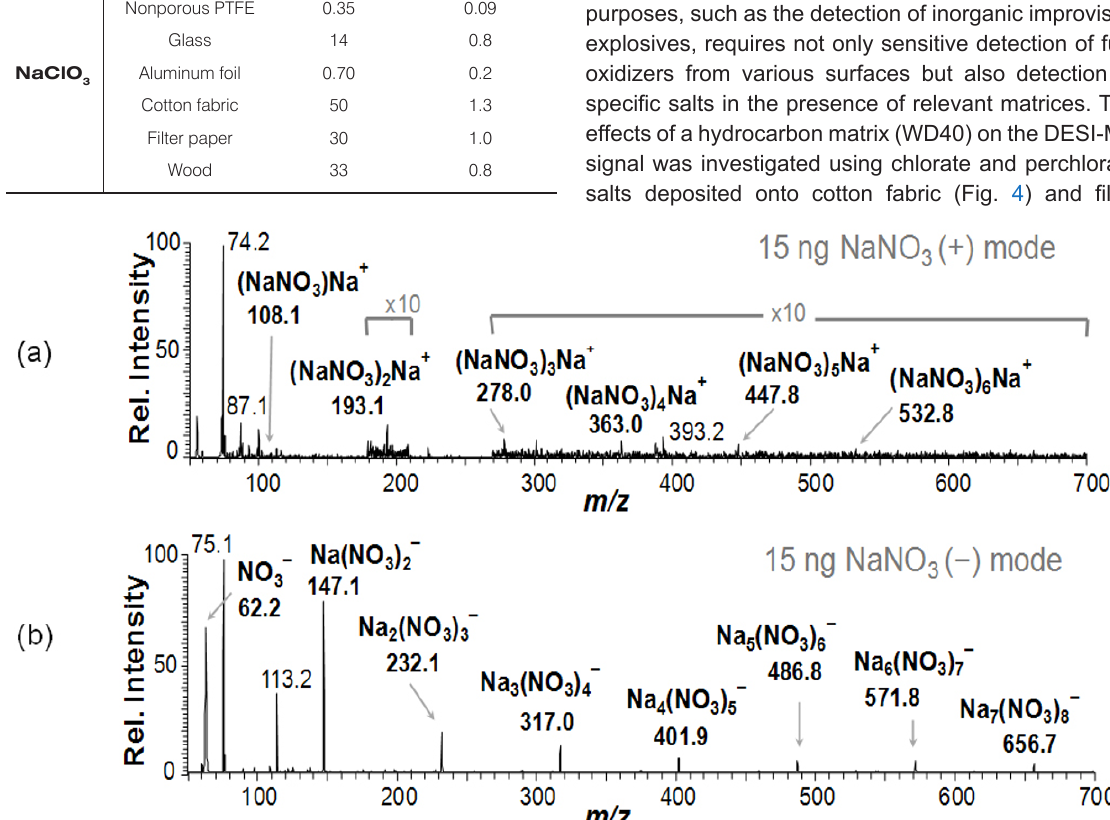
Figure 3. DESI mass spectra of 15 ng sodium nitrate deposited on nonporous PTFE: (a) recorded in positive ion mode, (b) recorded in negative ion mode. Ions of m/z 75.1, 74.2 and 113.2 (±0.1) are interpreted as originating from trace solvent impurities. They are commonly observed during positive ion mode DESI MS analysis of salts deposited on various surfaces.